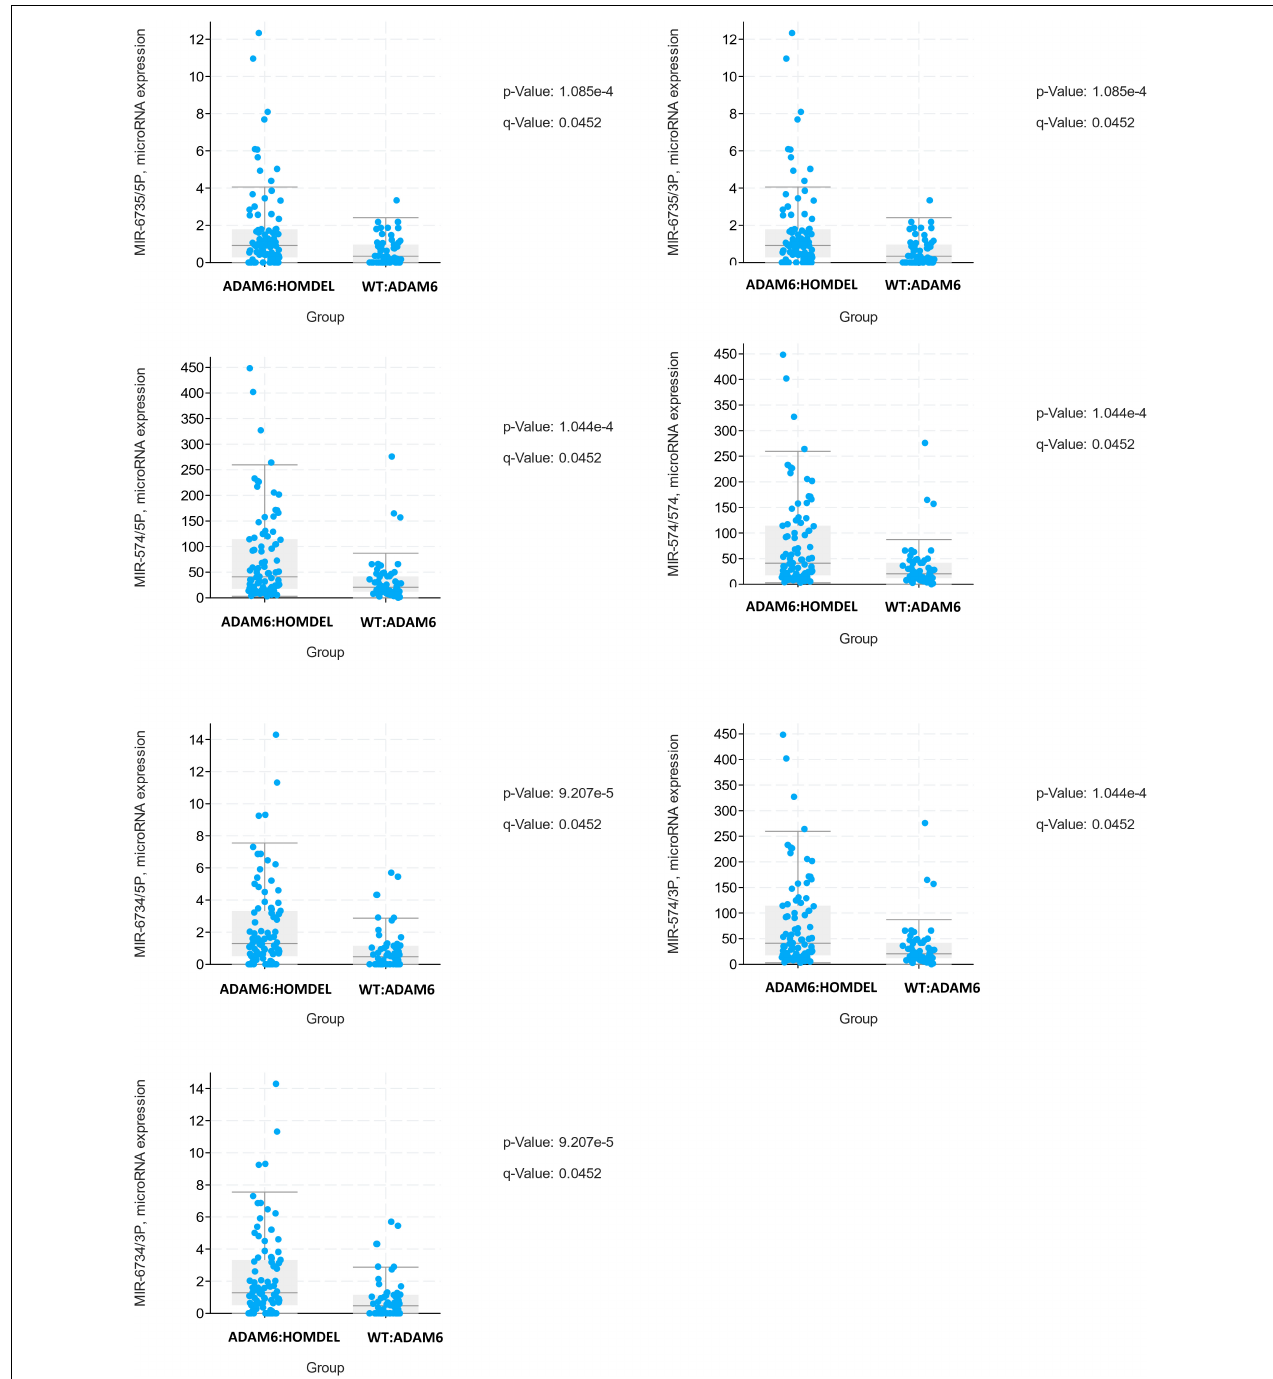
FIGURE 6 | The top statistically different miRNA between ADAM6:HOMDEL versus WT:ADAM6 patients.